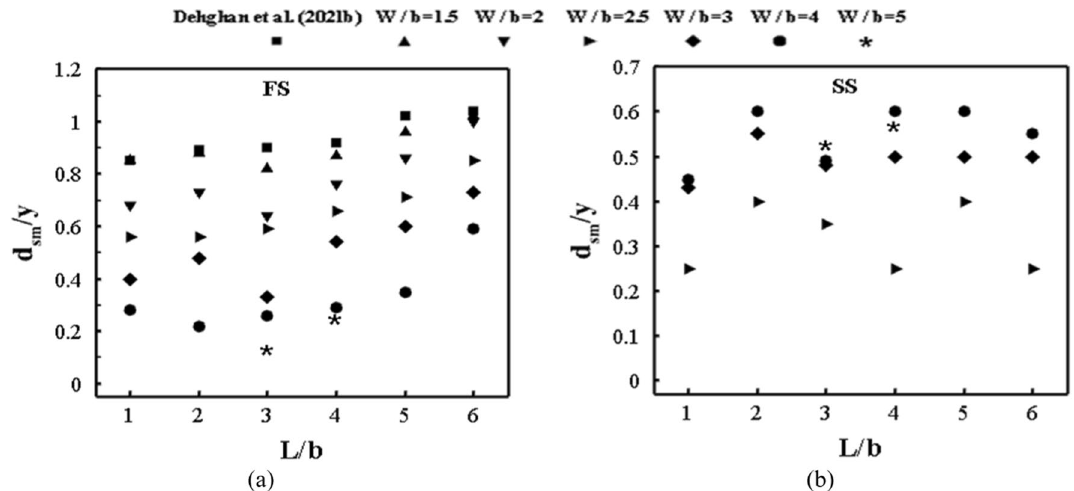
Fig. 5 Values of the maximum depth of scouring cavities created surrounding the rectangular piers and collars